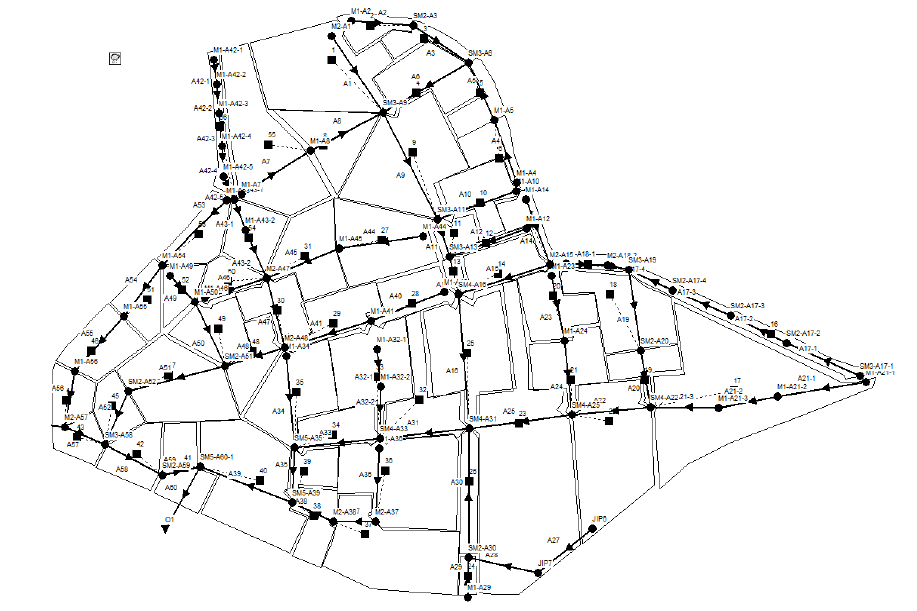
Figure 5. Layout of the drainage system. Table 5. Empirical values of the regional comprehensive runoff coefficient [29].